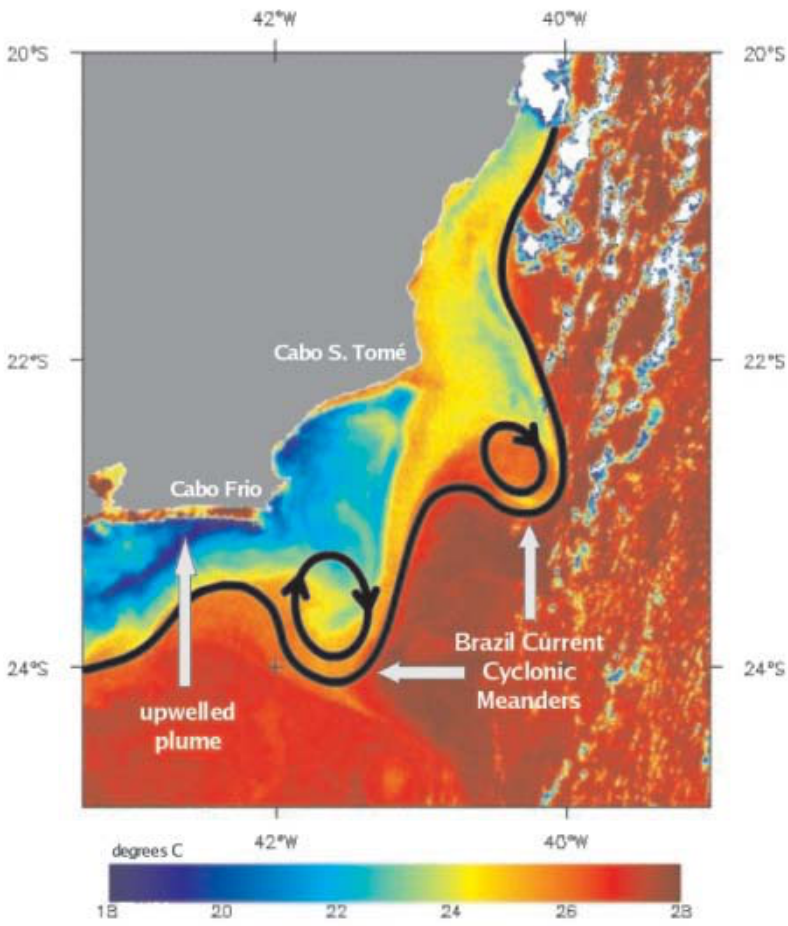
Fig. 2 – AVHRR image showing the coastal upwelling system off Cabo Frio and the Brazil Current meandering. Image provided by J.A. Lorenzzetti (INPE,